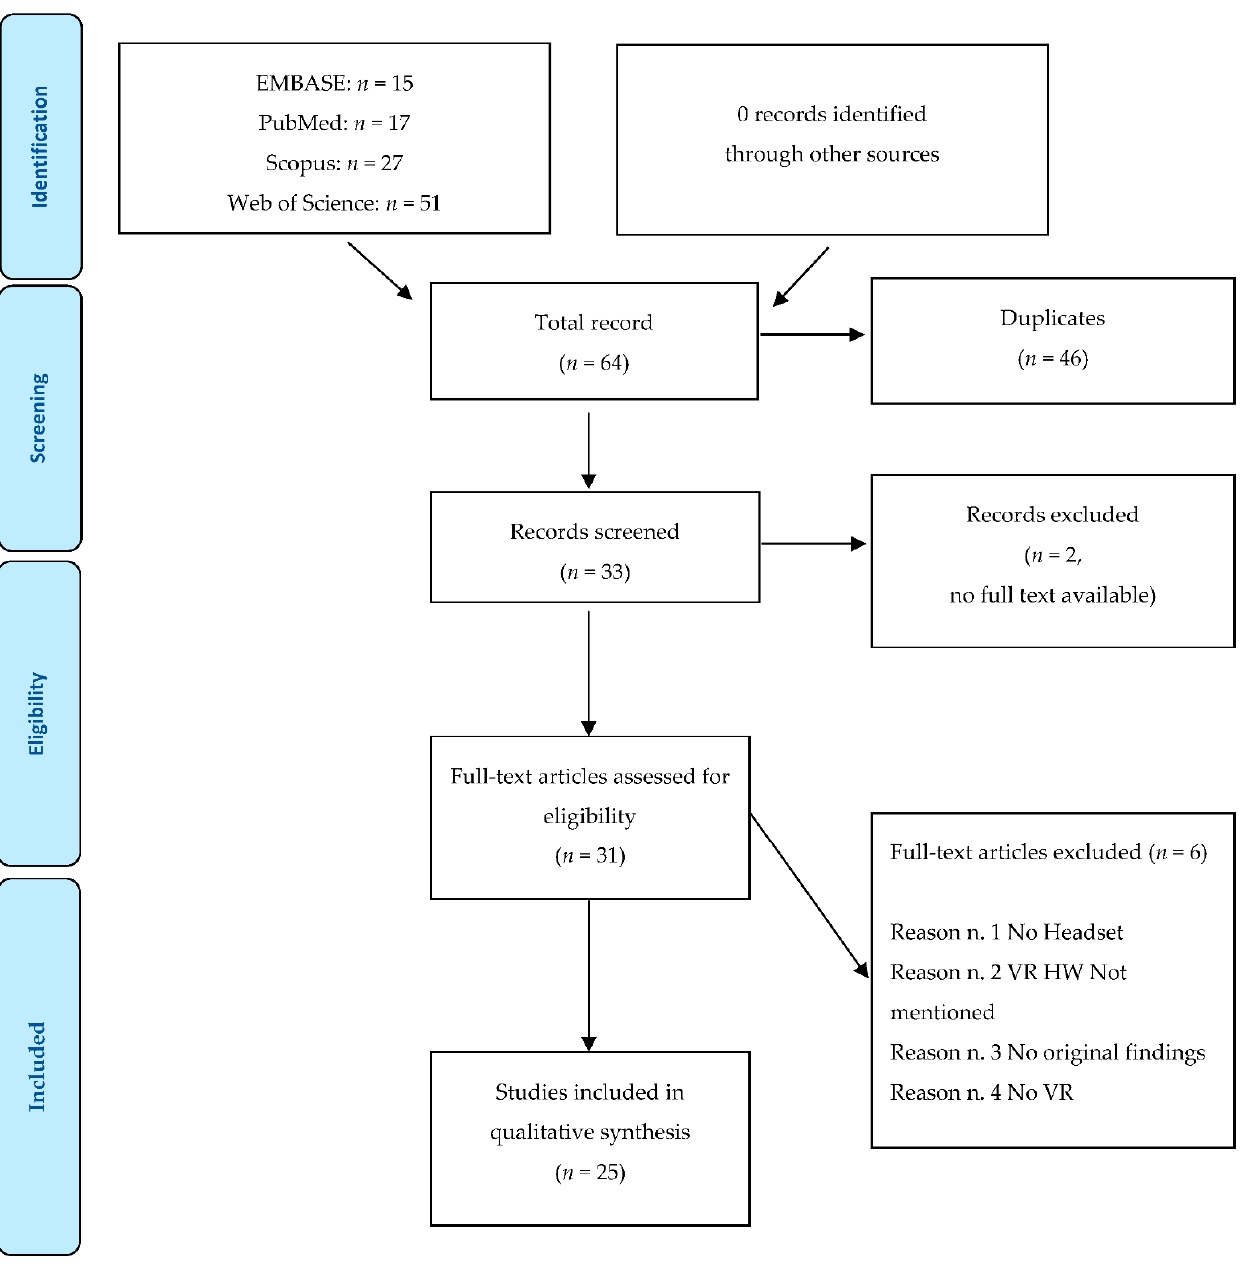
Figure 1. PRISMA flow diagram. Table 1. Relevant literature in body image perception, anorexia nervosa and virtual reality therapeutic applications.